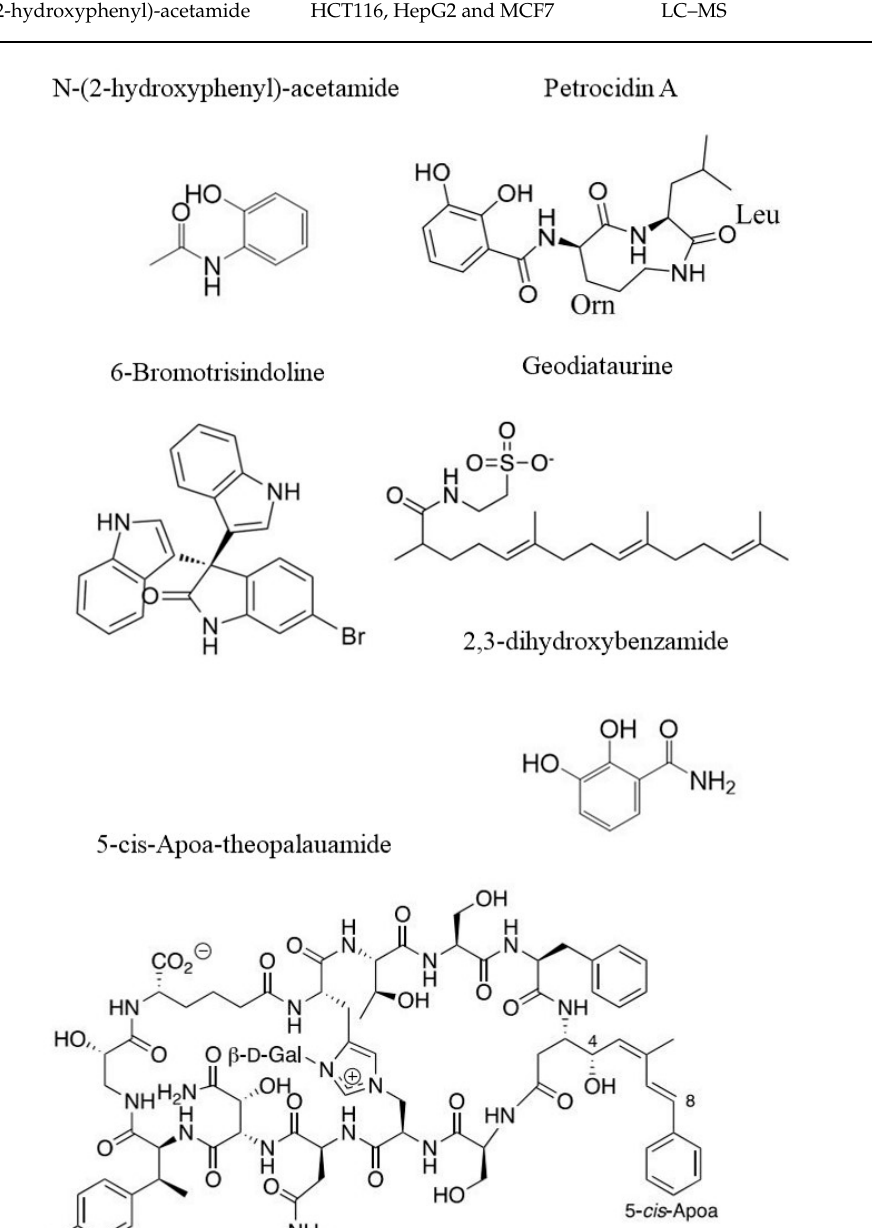
Figure 5. Examples of chemical structures of natural compounds from sponges: N -(2-hydroxyphenyl)-acetamide [108], Petrocidin A and 2,3-Dihydroxybenzamide [105], 6-Bromotrisindoline [94], Geodiataurine [98] and 5- cis -Apoa-theopalauamide [100].